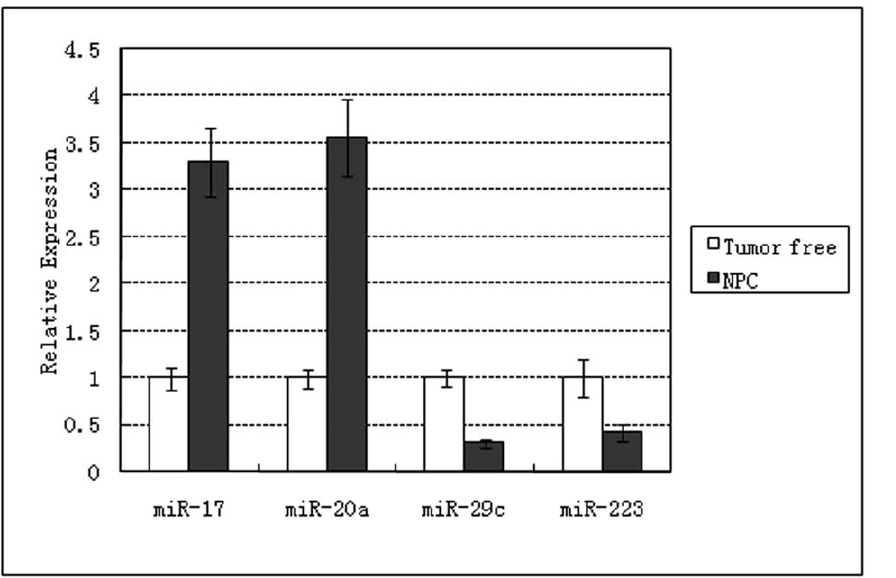
Figure 1. Expression of miR-17, miR-20a, miR-29c and miR-223 selected with miRNA array by a real-time quantitative Polymerase Chain Reaction (RT-qPCR), showing differentially expressed between NPC and non-cancerous group.